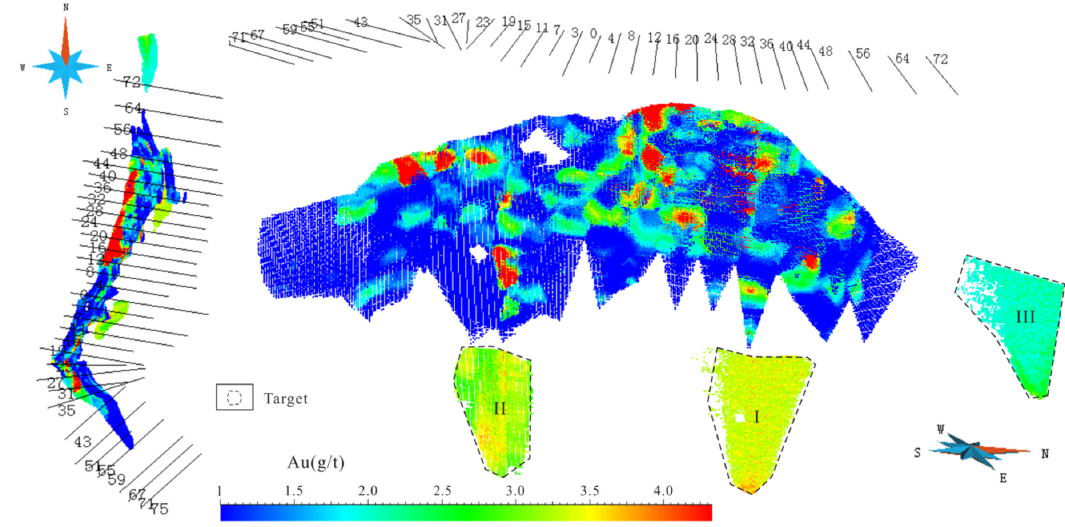
Figure 9. Targets determined by the 3D prospectivity modeling of the Axi gold deposit.